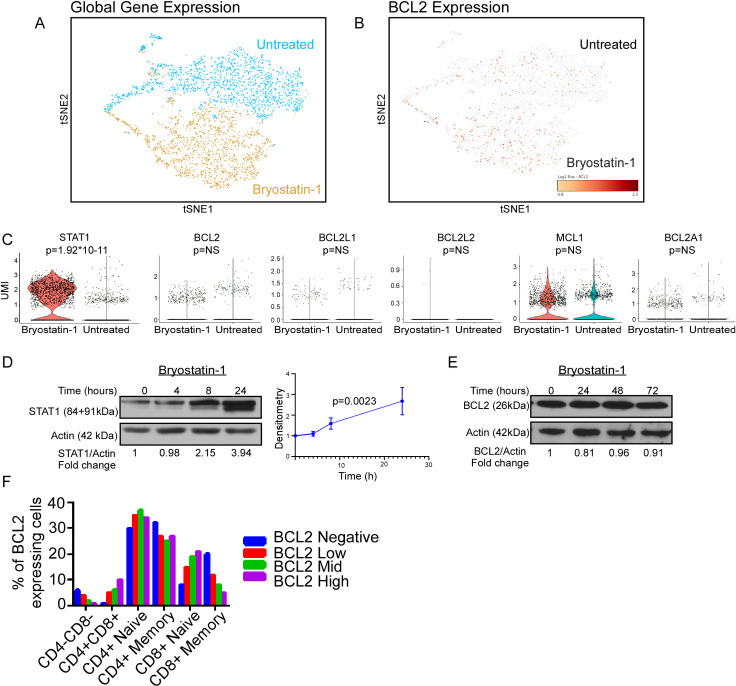
Cell-to-cell variability in BCL2 expression in CD4 T cells.A-C) Single-cell RNAseq (scRNA) was performed on primary CD4 T cells from an ART-suppressed, HIV positive donor treated with bryostatin or control for 24 hours. A) tSNE plot of whole transcriptome scRNA sequencing showing global gene expression differences. B) tSNE plot showing BCL2 positive cells (brown) from both the untreated and bryostatin-treated CD4 T cells. C) Violin plots comparing expression of STAT1 and anti-apoptotic BCL2 family proteins between cells treated with bryostatin and untreated cells. D-E) Western blots showing changes: D) in STAT1 levels over 24 hours in CD4 T cells with graph showing changes of STAT1 over time (STAT1/actin ratio across 3 replicates). Significance (p<0.0023) was determined using a linear regression with the slope being significantly non-zero. E) BCL2 expression of bryostatin-treated CD4 T cells over 72 hours. F) Flow cytometry for intracellular BCL2 expression in T cell subsets was performed. Depicted is aggregated data from (n = 3) HIV positive subjects.